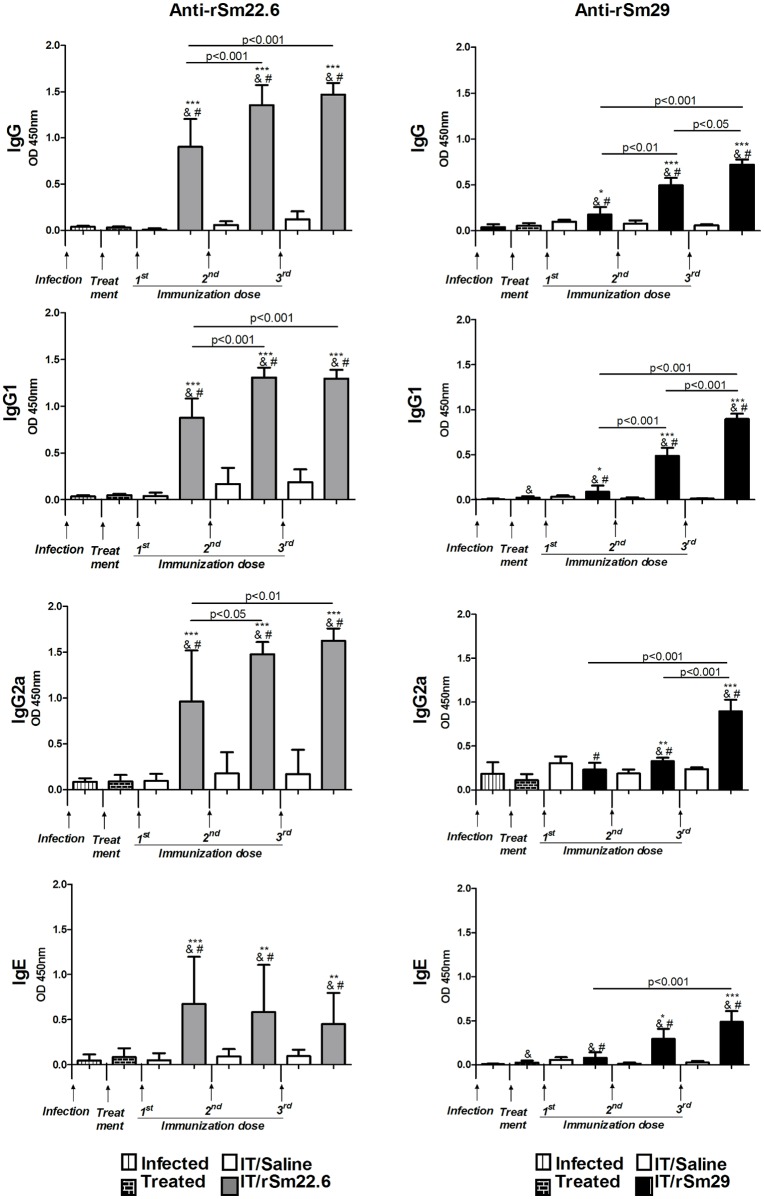
Kinetics of specific anti-rSm22.6 or anti-rSm29 antibodies production induced by immunization.Sera from 10 animals/group were collected forty-five days after infection, fifteen days after treatment and two weeks after each immunization dose. The levels of specific IgG, IgG1, IgG2a, IgE against rSm22.6 or against rSm29 were determined by ELISA. Sera dilution was: 1:1.000 (IgG and IgG1—rSm29 tests), 1:100 (IgG2a—rSm29 test), 1:600 (IgG—rSm22.6 test), 1: 1.000 (IgG1—rSm22.6 test), 1:400 (IgG2a—rSm22.6 test) or 1:40 (IgE—rSm22.6 and rSm29 test). Bars represent the mean absorbance values measured at 450 nm ± SD (Standard Deviation). Arrows indicate the timing of infection, treatment and immunization. Statistically significant differences between rSm22.6 or rSm29 group and saline control group is denoted in the graphic by one asterisk (p<0.05), two asterisks (p<0.01) or three asterisks (p<0.001). Statistically significant difference between the immunization doses is pointed in the graphic. &: difference compared to infected mice; #: difference compared to treated mice.